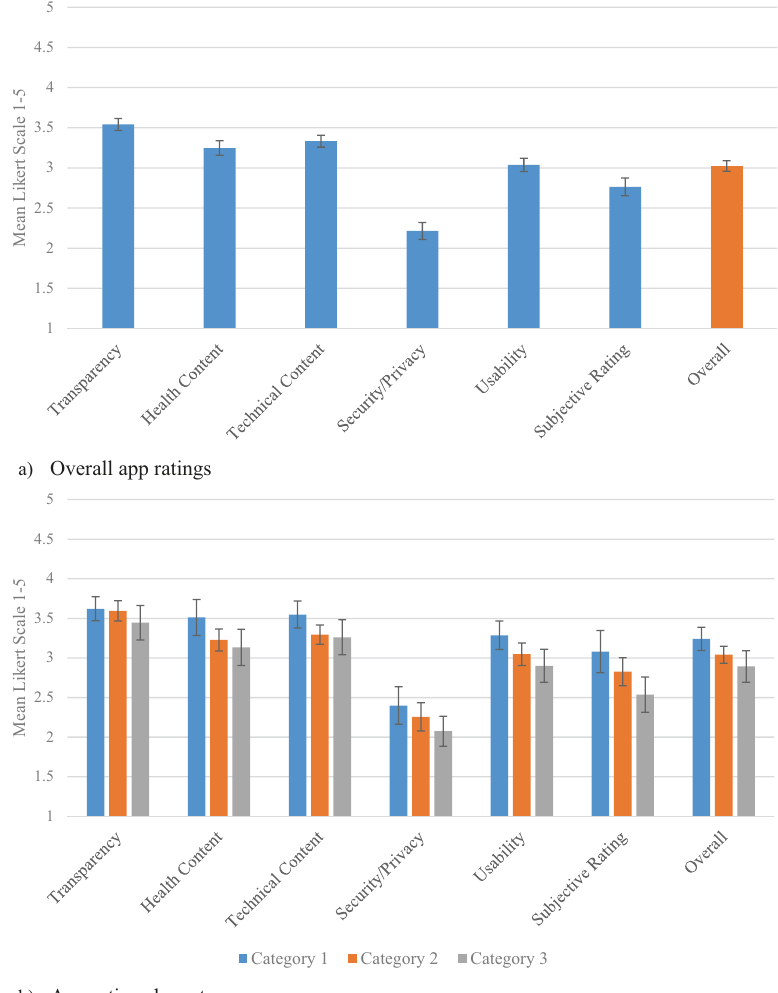
Fig. 2 App ratings. a Overall app ratings. b App ratings by category. The error bars represent 95% con fi dence intervals. See Supplementary Table 4 for detailed ratings.